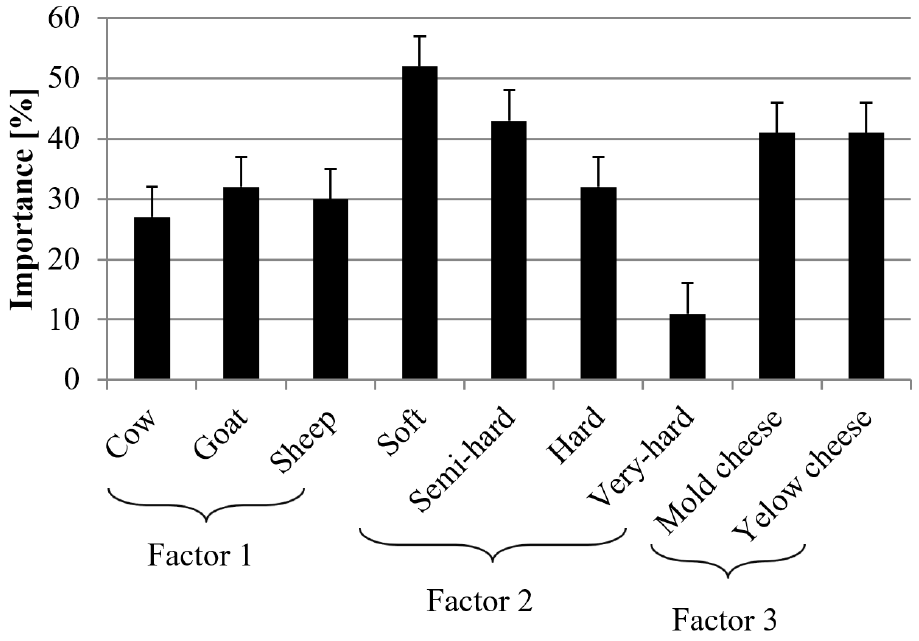
Figure 2. Ranking of priority of factors determining the content of fatty acid in studied commercial cheeses. Ranking on a scale of 0 (low importance) to 100 (high importance), n =